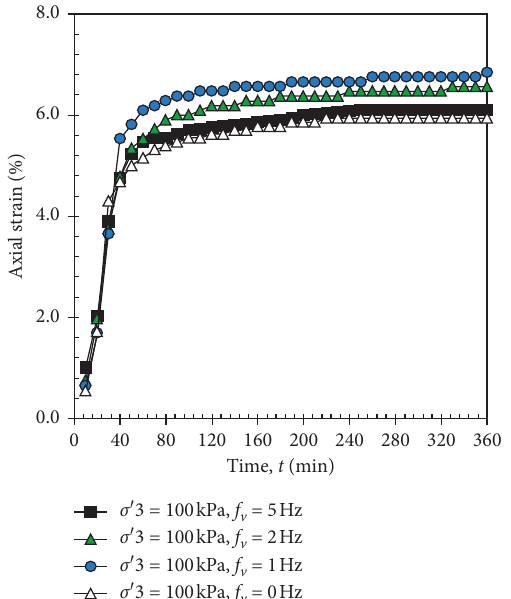
Figure 5: Variation of axial strain with time.